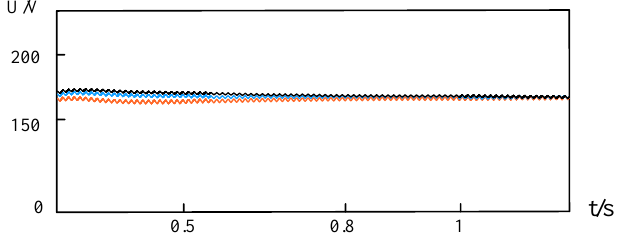
Figure 11. Voltage value based on voltage balance strategy under PI control.